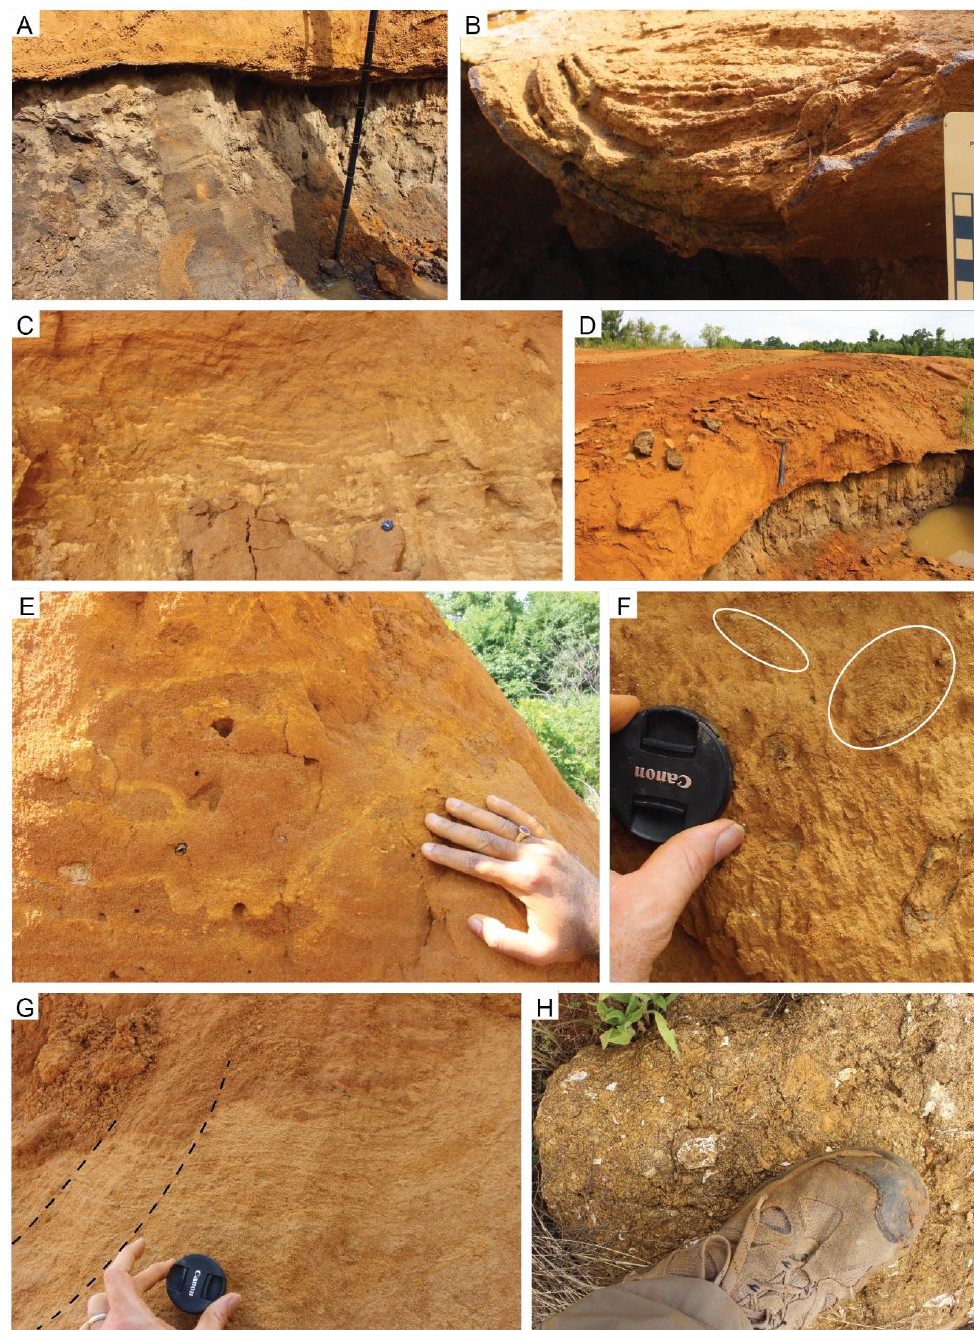
Figure 6. Sand and limestone lithofacies. ( A ) Sharp contact between carbonaceous sand lithofacies and massive sand lithofacies. Jacob staff marked in dm. ( B ) Fe-rich concretion at contact between carbonaceous sand and massive sand lithofacies. Scale is in cm. ( C ) Wavy-bedded sand lithofacies. 5.5 cm diameter lens cap for scale. ( D ) Massive sand lithofacies overlying carbonaceous sand lithofacies. Note resistant layers of Fe-cemented sand. Rock hammer is 32 cm long. ( E ) Ophiomorpha in the massive sand lithofacies at the southern site. Hand for scale. ( F ) Thalassinoides in the massive sand lithofacies at the northern site. Note concentric laminae (ovals). Lens cap is 5.5 cm in diameter. ( G ) Ripple-laminated sand lithofacies. Dashed lines highlight slump planes. Lens cap is 5.5 cm in diameter. ( H ) Sandy packstone lithofacies at northern site. Size 12 boot for